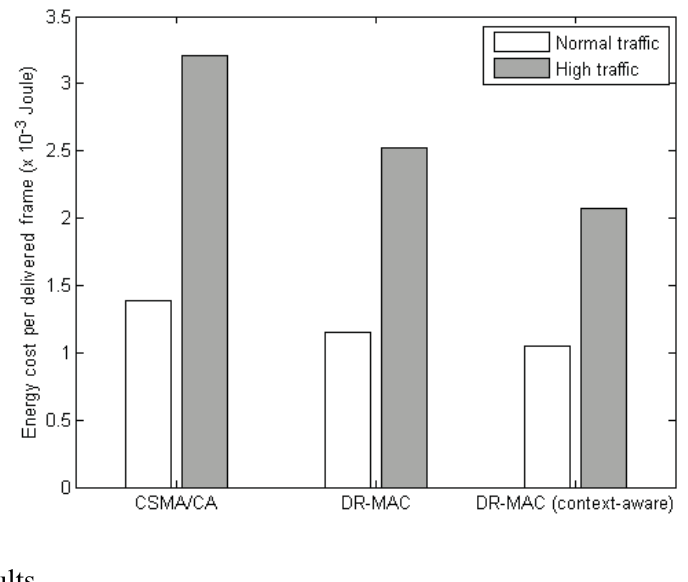
Figure 10. Energy cost for a successful frame delivery by MAC protocols.